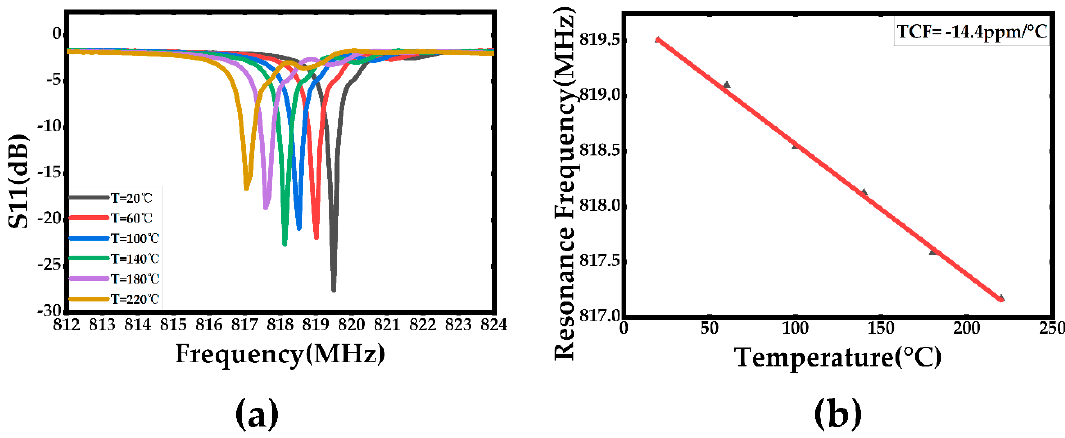
Figure 14. ( a ) The temperature dependent S11 parameters with different temperature, ( b ) the temperature dependent resonance frequency with different temperature.